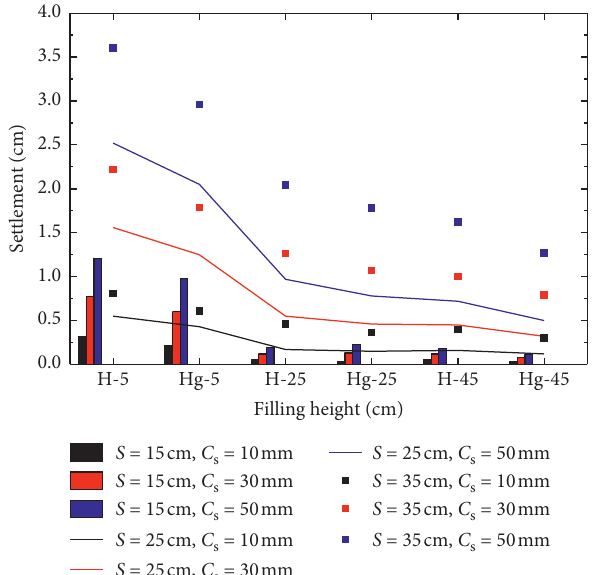
Figure 13: Variation of the settlement with different consolidation